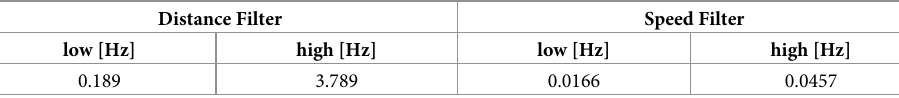
Table 3. Average optimal Butterworth filter cutoff